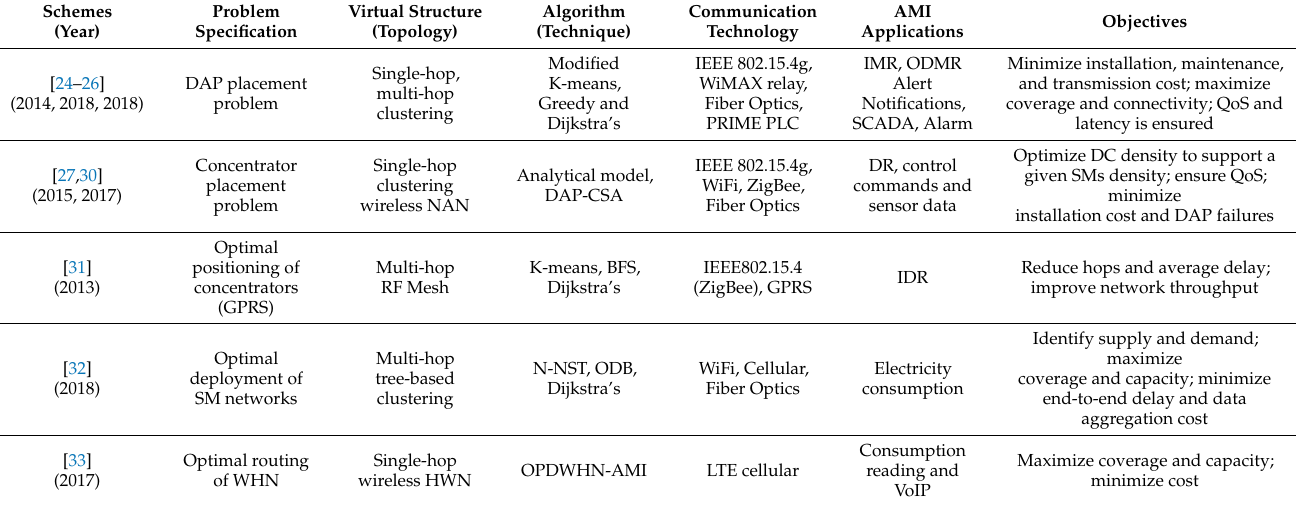
Table 1. Comparison of existing AMI